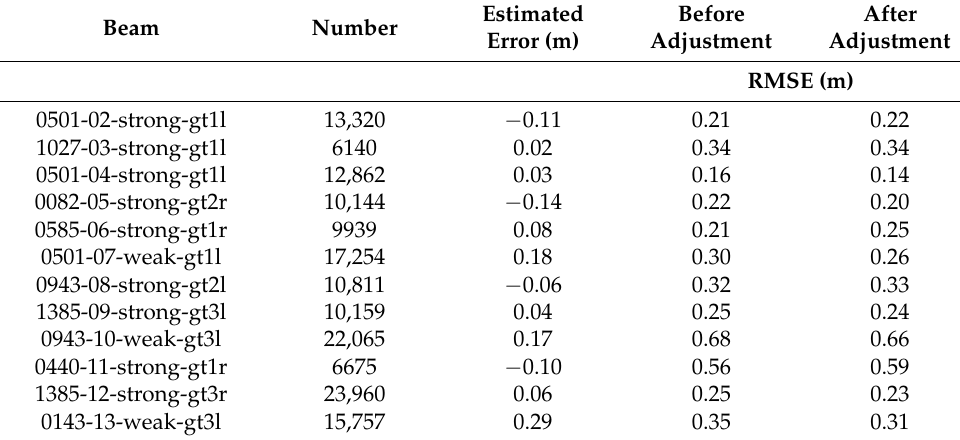
Figure 10. Histogram of the estimated systematic bias of all beams (blue columns) of ICESat-2 measured data. The beams marked with red pentagram are the result of the focus description. Table 5. Comparison of data accuracy before and after crossover adjustment based on ICESat-2 measured data.